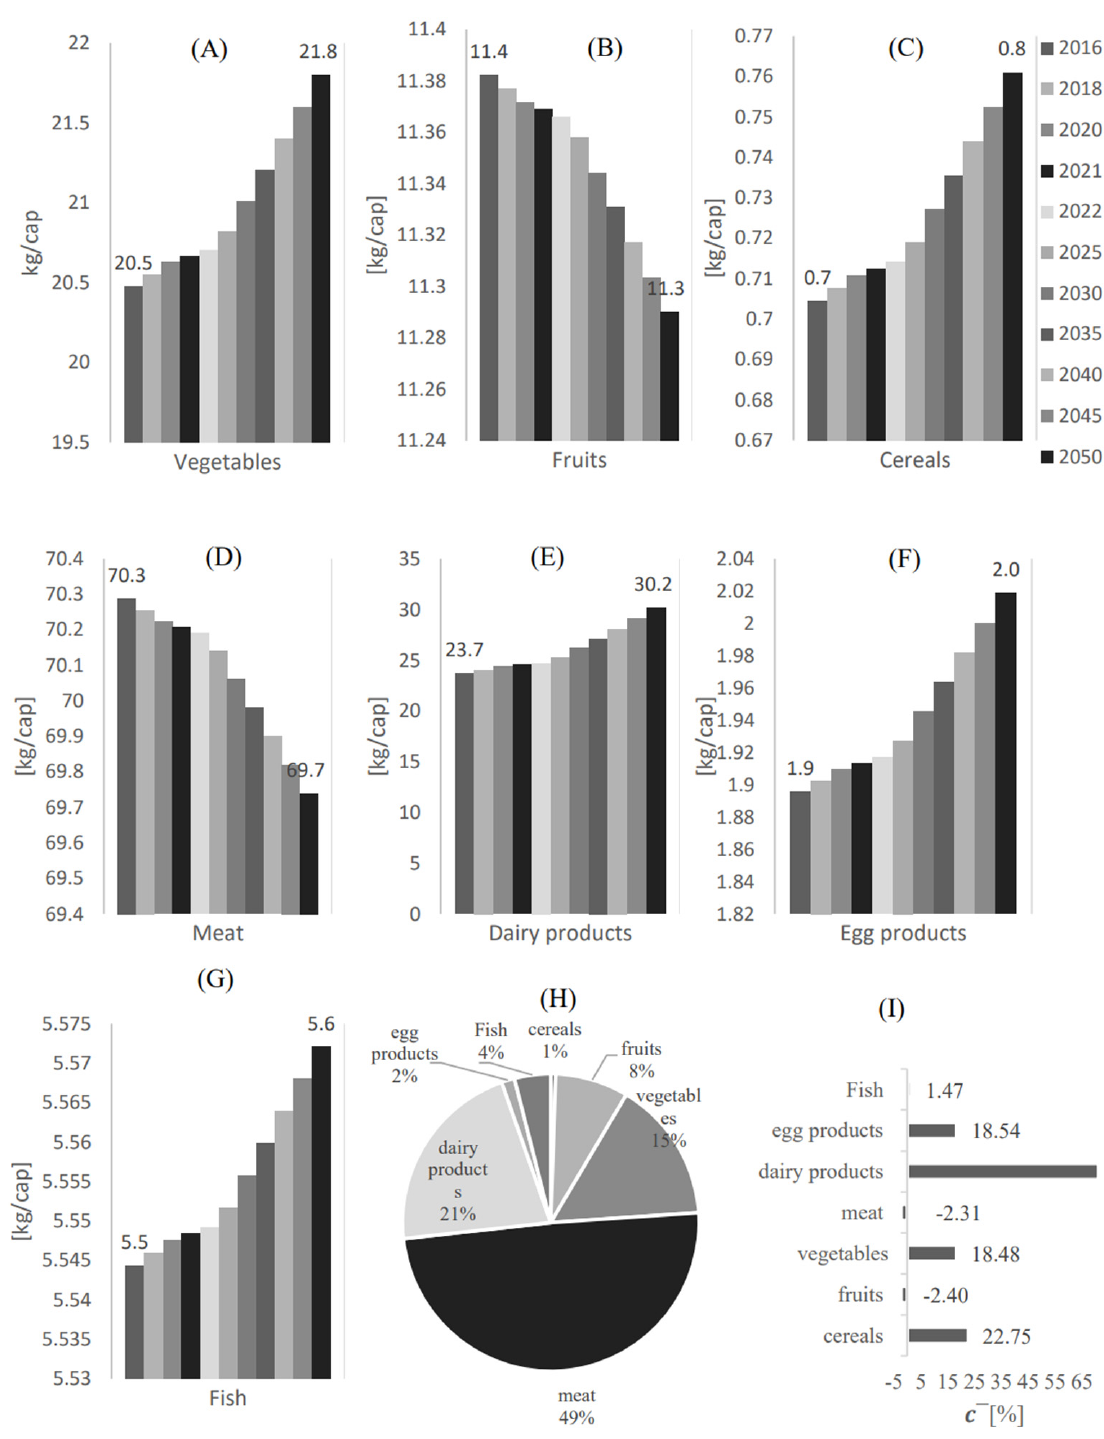
Figure 3. The local food supply per capita profile from 2016 to 2050 in Qatar for ( A ) Vegetables, ( B ) Fruits, ( C ) Cereals, ( D ) Meat, ( E ) Dairy products, ( F ) Egg products, and ( G ) Fruit. ( H ) The local food supply percentage [Mass %] for each food category with respect to the overall local food supply. ( I ) The average local food supply change factor.